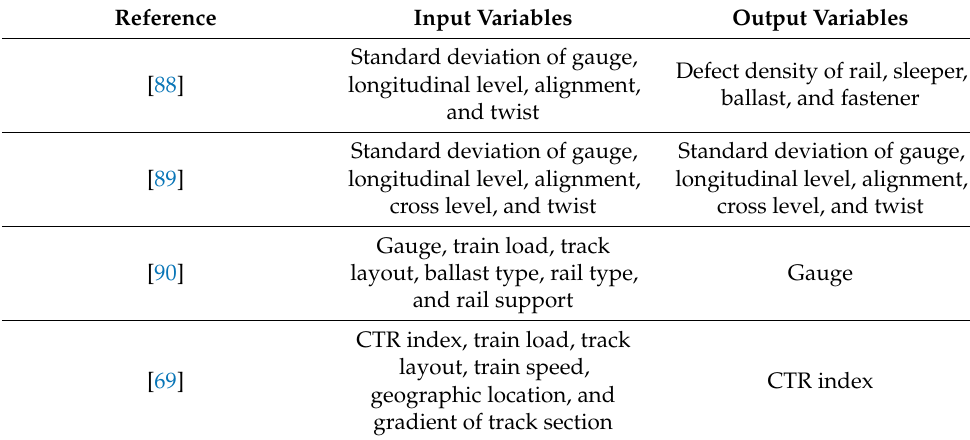
Table 6. Input and output variables in existing